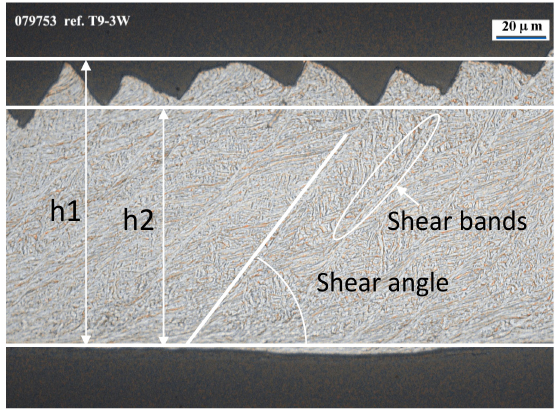
Figure 9. Metallographic analysis of the cross section of the chip for a workpiece produced by WAAM.